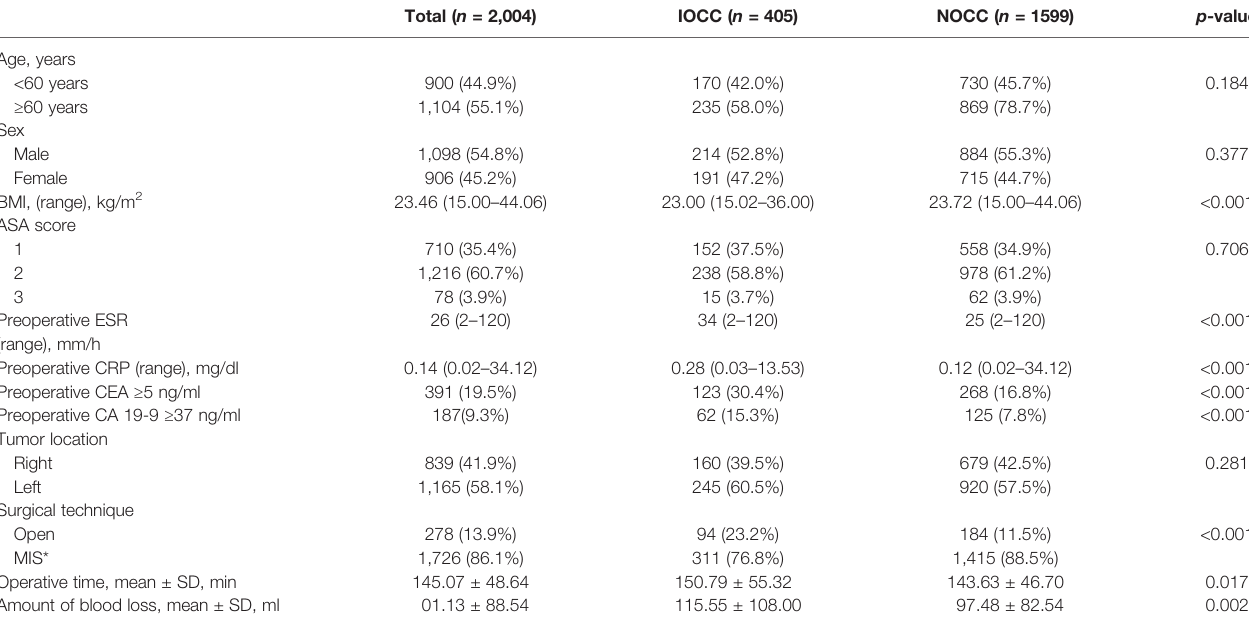
TABLE 1 | Baseline characteristics of incomplete obstructive colon cancer (IOCC) and non-obstructive colon cancer